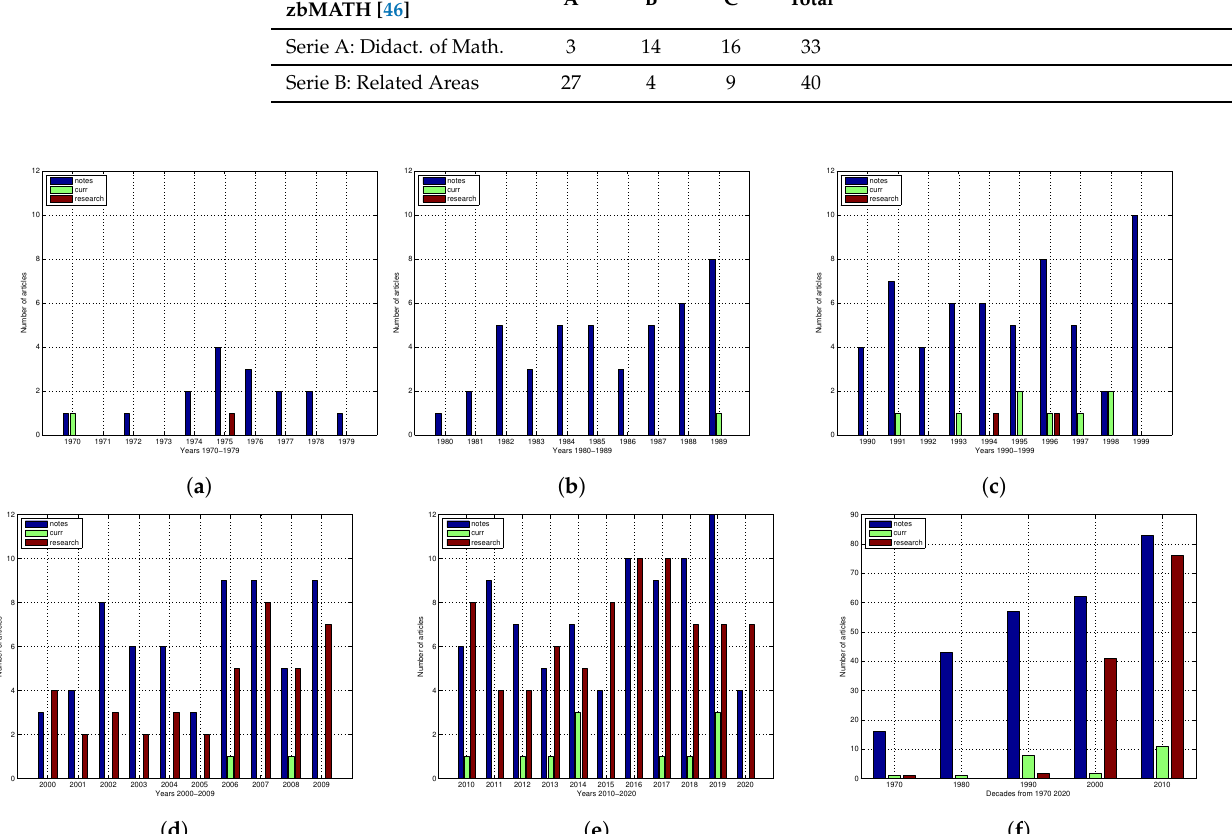
Figure 2. Number of articles from 1970 to 2020. Here the abbreviation notes, curr, and research are used for the types notes , curriculum and research in classroom , respectively. ( a ) Articles from 1970 to 1979. ( b ) Articles from 1980 to 1989. ( c ) Articles from 1990 to 1999. ( d ) Articles from 2000 to 2009. ( e ) Articles from 2010 to 2020. ( f ) Articles by decades from 1970 to